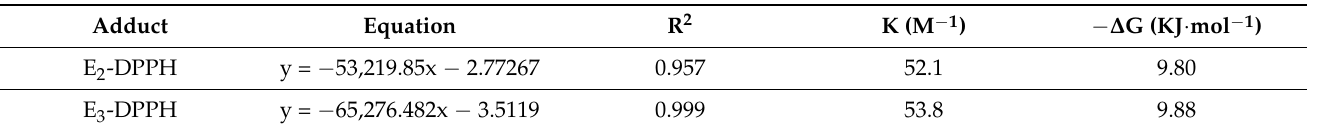
Table 11. Binding constant and binding free-energy values for E 2 and E 3 with DPPH from UV data at 298